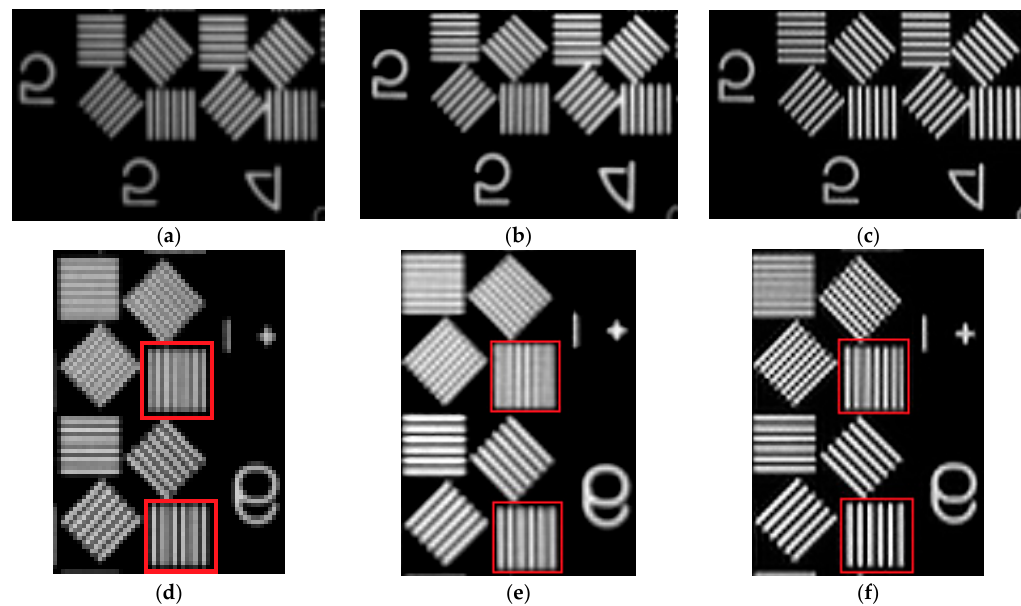
Figure 14. Details of the experiment. ( a ) Part 1 of origin image; ( b ) Part 1 of Figure 14b; ( c ) Part 1 of Figure 14c; ( d ) Part 2 of origin image; ( e ) Part 2 of Figure 14b; ( f ) Part 2 of Figure 14c.